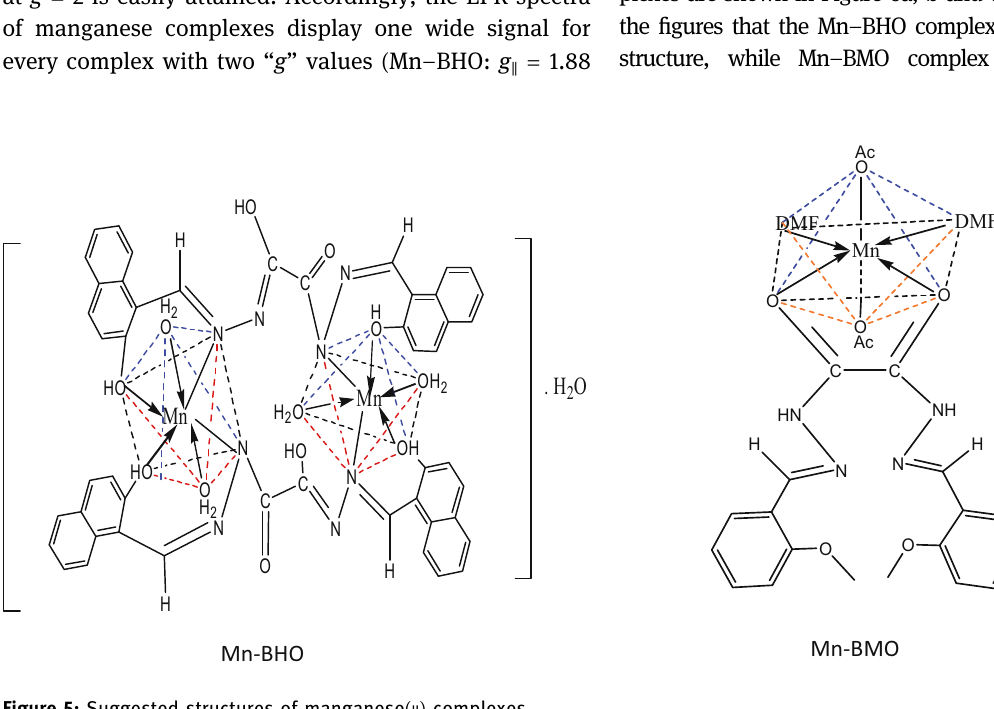
Figure 5: Suggested structures of manganese ( II )